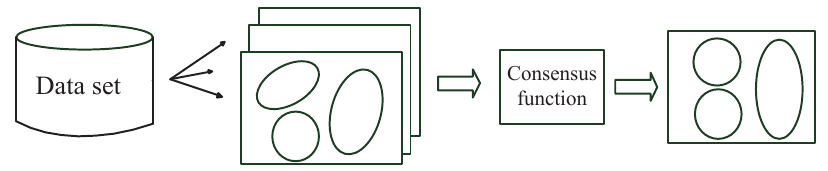
Figure 1. Flow chart of ensemble